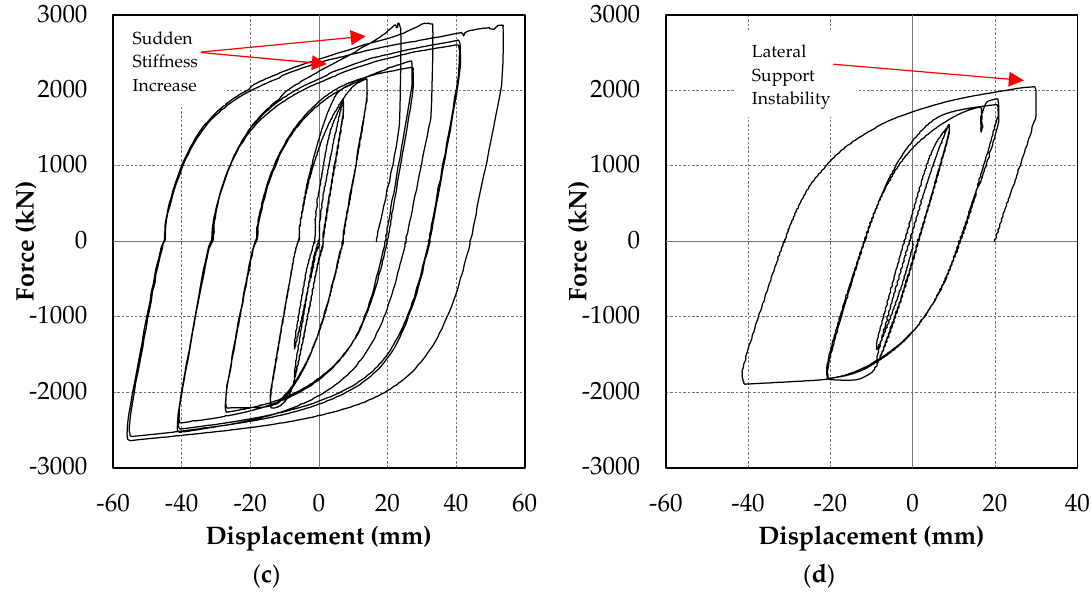
Figure 6. Hysteretic responses. Specimens ( a ) 1, ( b ) 2, ( c ) 3, and ( d ) 4.